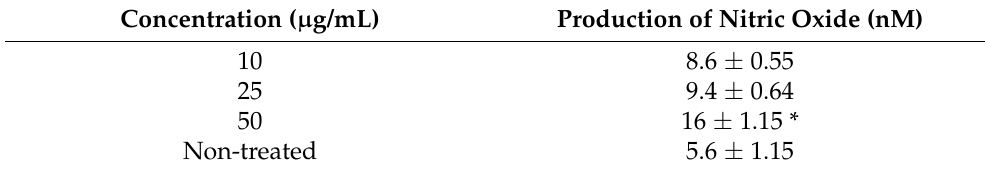
Table 5. Comparison of NO production in J774-A1 macrophage cells after treatment with various concentrations of Z. spina-christi extract.